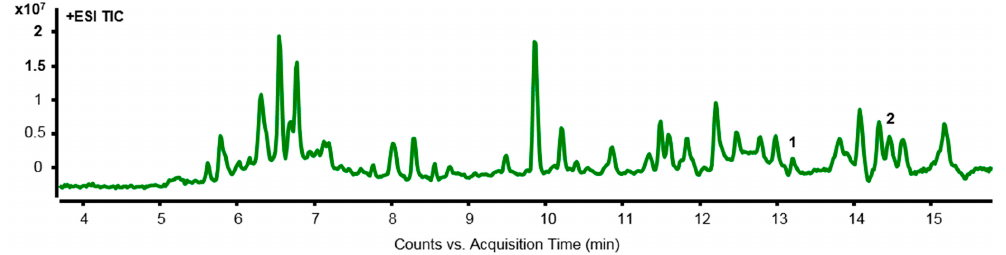
Figure 7. LC-MS chromatography of ES methanol extract. The overall chromatogram of ES is shown, and the peaks of compounds that have the potential to act as active substances are numbered. The names of compounds corresponding to each peak number are as follows; 1: Evonine, 2: Acanfolioside. Table 1. List of compounds detected in ES Methanol extracts using LC-MS. No. Compound R.T (min) Mass